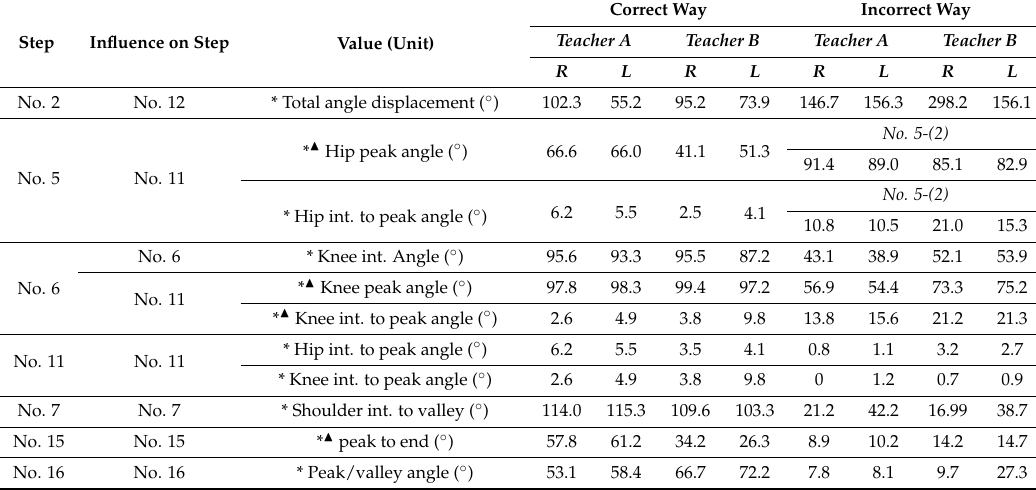
Table 4. Results of joint